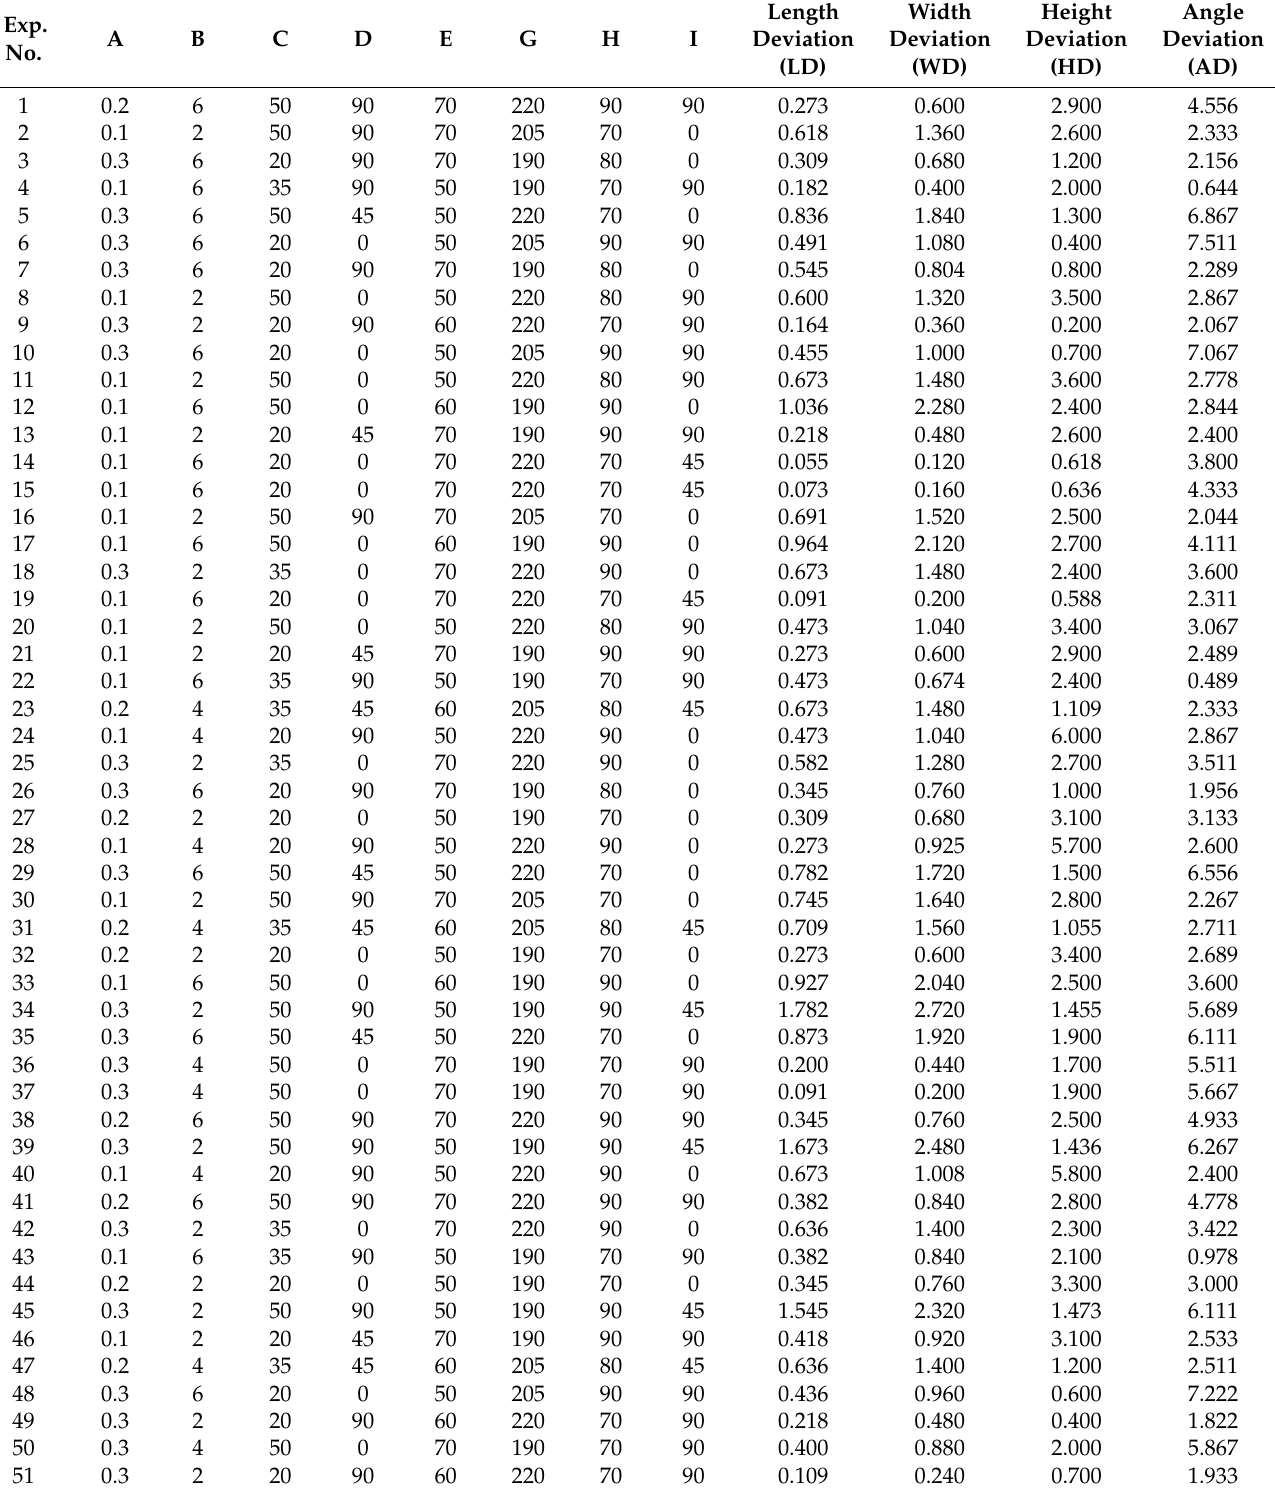
Table A1. Experimental design and measured